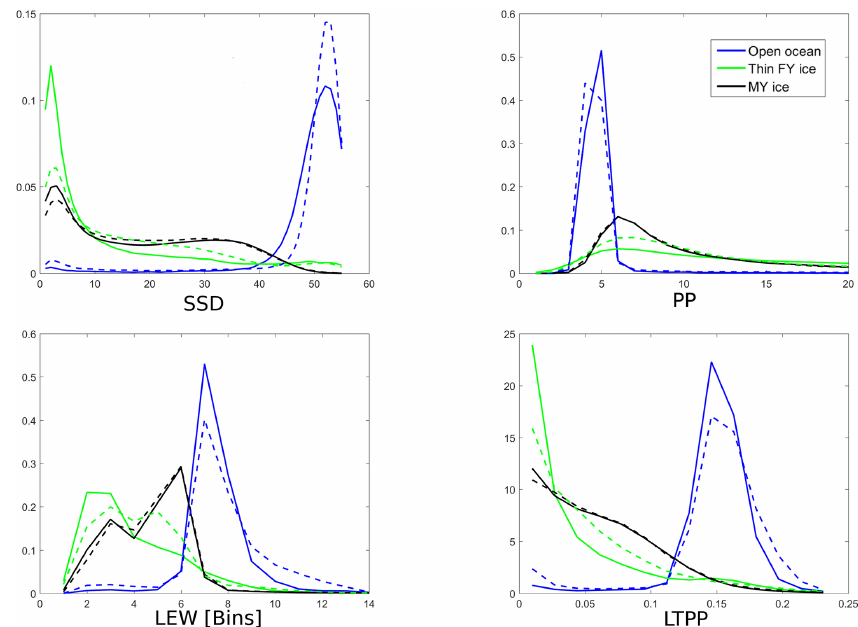
Figure 3. Normed distributions of waveform parameters: SSD (top left panel), PP (top right panel), LeW (low left panel), and LTPP (low right panel) for the period 1–15 November (solid lines) and 16–30 November (dashed lines)